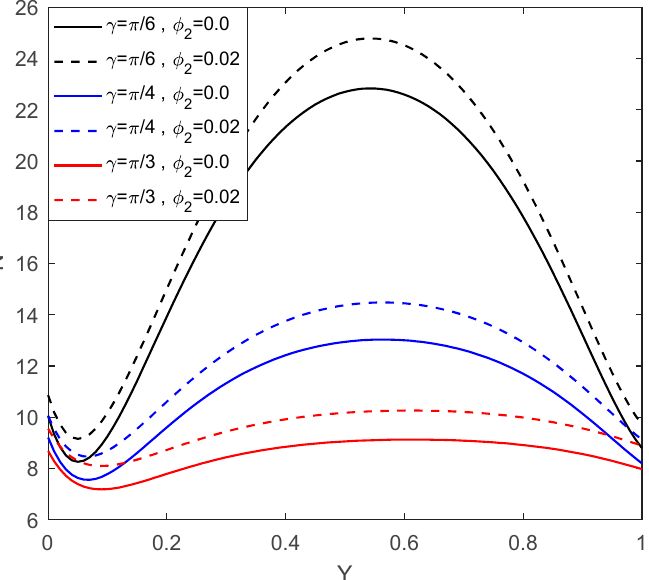
(cid:3095) , π , π , for , (cid:3095) , (cid:3095) , for 6 3 4 (cid:2874) (cid:2872) (cid:2871) = 0.1, 𝜑 = 0.0 (regular nanofluid) and with a (cid:2869) (cid:2870)